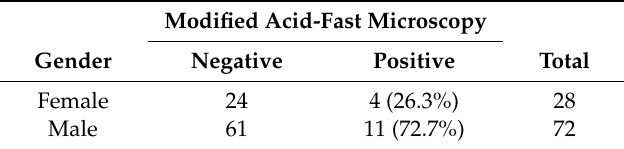
Table 1. Positive cryptosporidiosis among